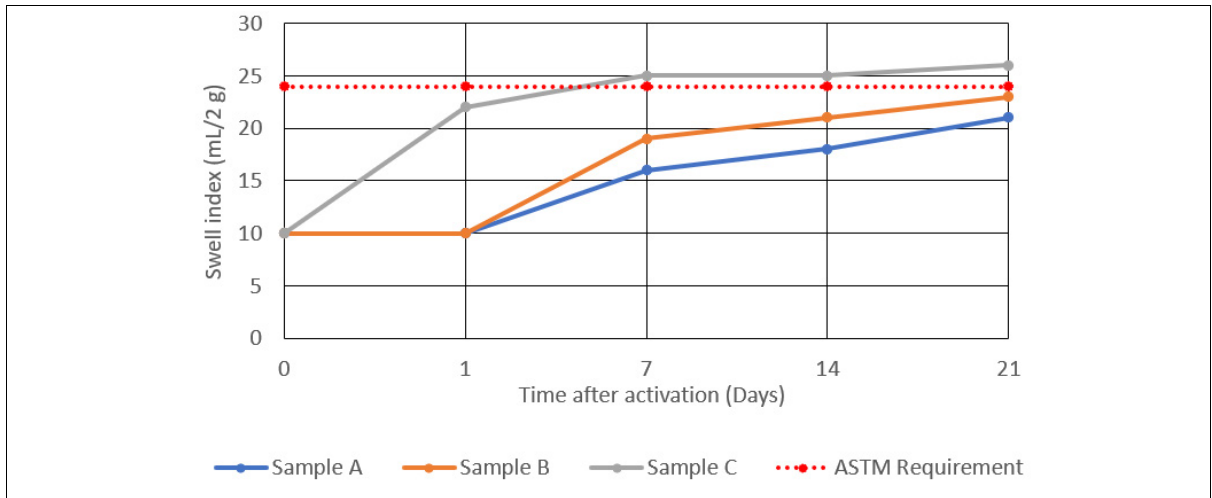
Figure 5: Swell index at various time intervals after activation of